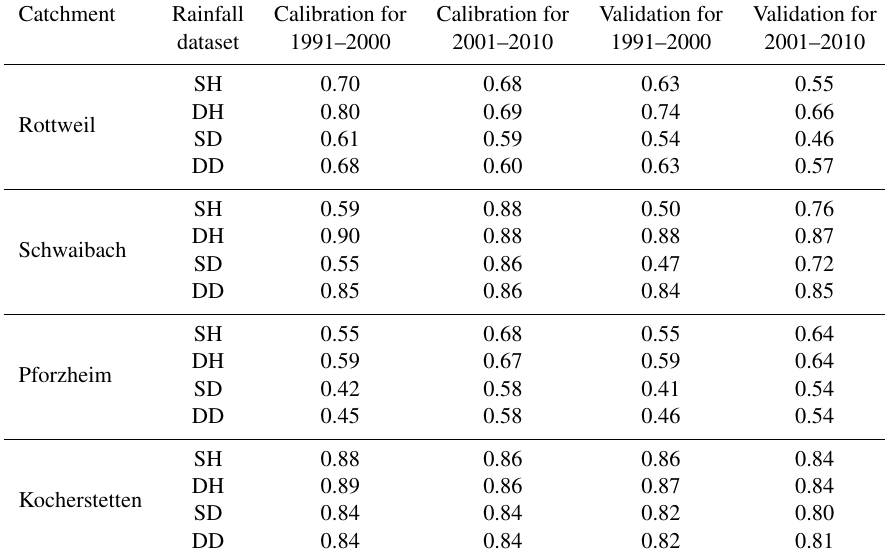
Table 4. Average NS model performance for the distributed HBV model. Catchment